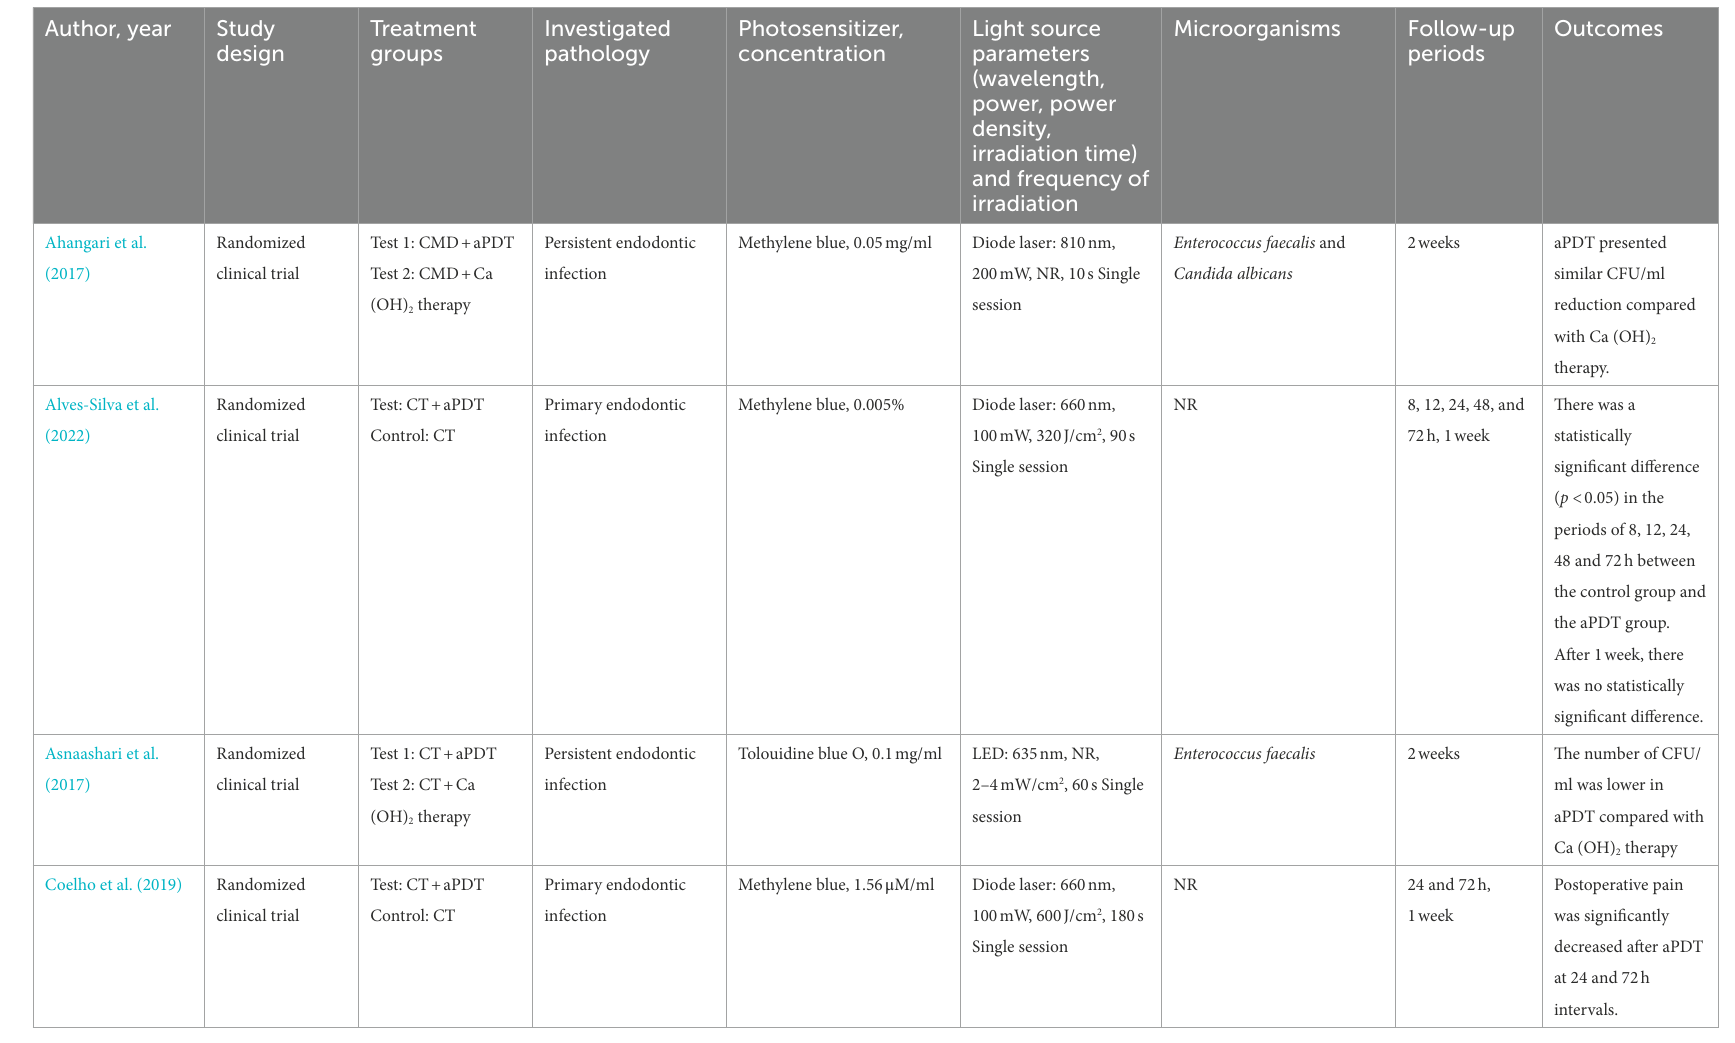
TABLE 3 aPDT treatment in patients with endodontic